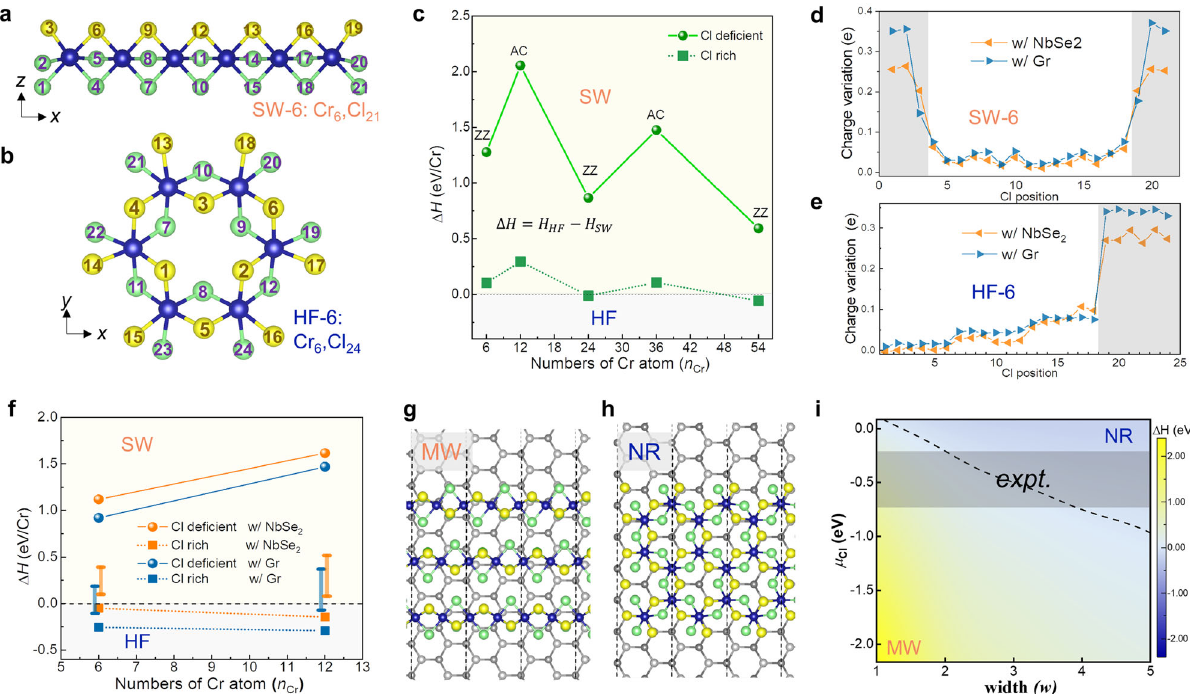
Fig. 4 | Theoretical understanding of the 1D phase growth and the 1D – 2D transformation. a Side view of SW-6. b Top view of HF-6. The upper and lower surface Cl atoms are represented by yellow and green balls, respectively. c Plot of Δ H between the free-standing SW and HF at the Cl-rich (green square) and Cl- de fi cient (green circle) extremes as a function of n Cr . The HFs with zig – zag (ZZ) edges ( n Cr =6, 24, and 54) are more stable than the arm-chair (AC) ones ( n Cr =12 and 36). d , e Plots of the charge variations for each individual Cl atom in SW-6 ( d ) and HF-6 ( e ) on the NbSe 2 (orange) and graphene (blue) substrates. The indices of